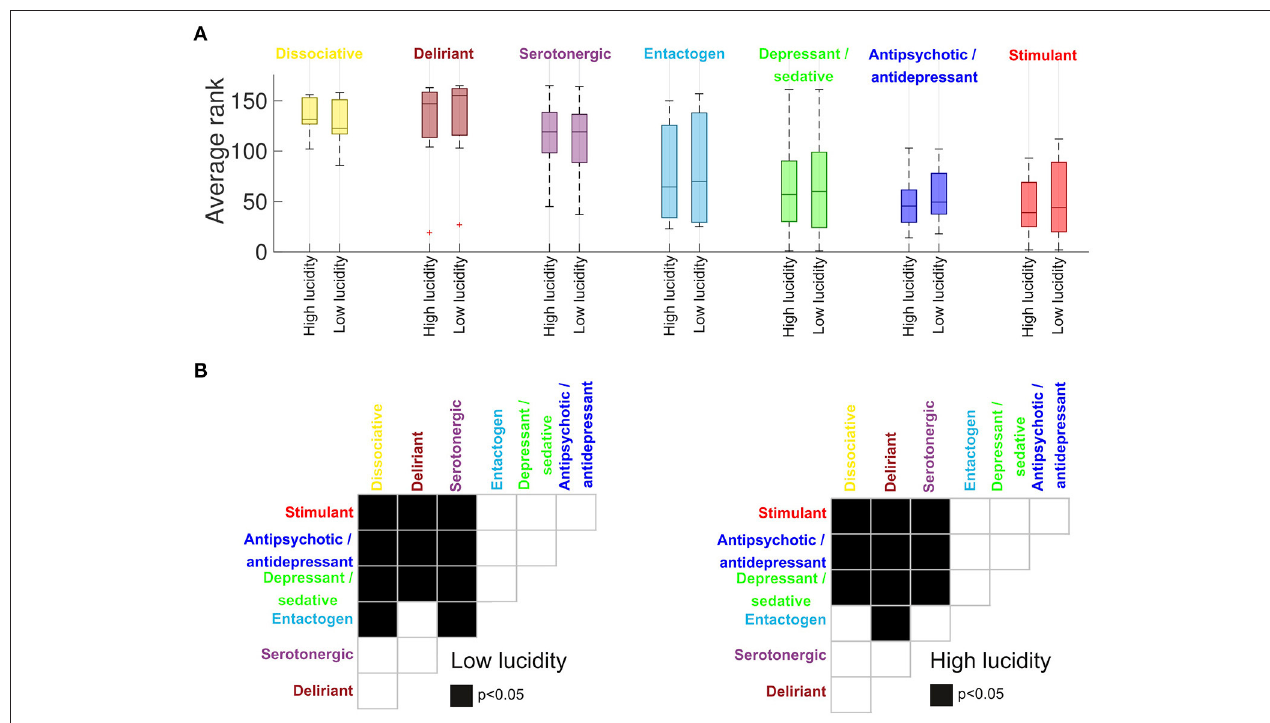
FIGURE 3 | (A) Average substance rank (per category) in terms of the similarity of the reported effects to high/low lucidity dream reports (median ± 25th and 75th percentiles, “ + ” represents outliers). Higher numbers correspond to higher similarity (the highest possible rank is 165). The categories “oneirogen,” “MAOI,” and “other” were excluded from this figure due to their small sample size ( n ≤ 6). The drug category presented a significant effect on the similarity with dream reports ( F = 31.34, p < 0.0001, multi-factor ANOVA), while the interaction between dream lucidity and similarity with dream reports was non-significant ( F = 0.02, p = 0.88). (B) Post-hoc Wilcoxon signed-rank tests for the difference in the similarity to dreams for each pair of drug categories. Black squares represent significant differences ( p < 0.05) for the pair of drug categories in the corresponding rows and